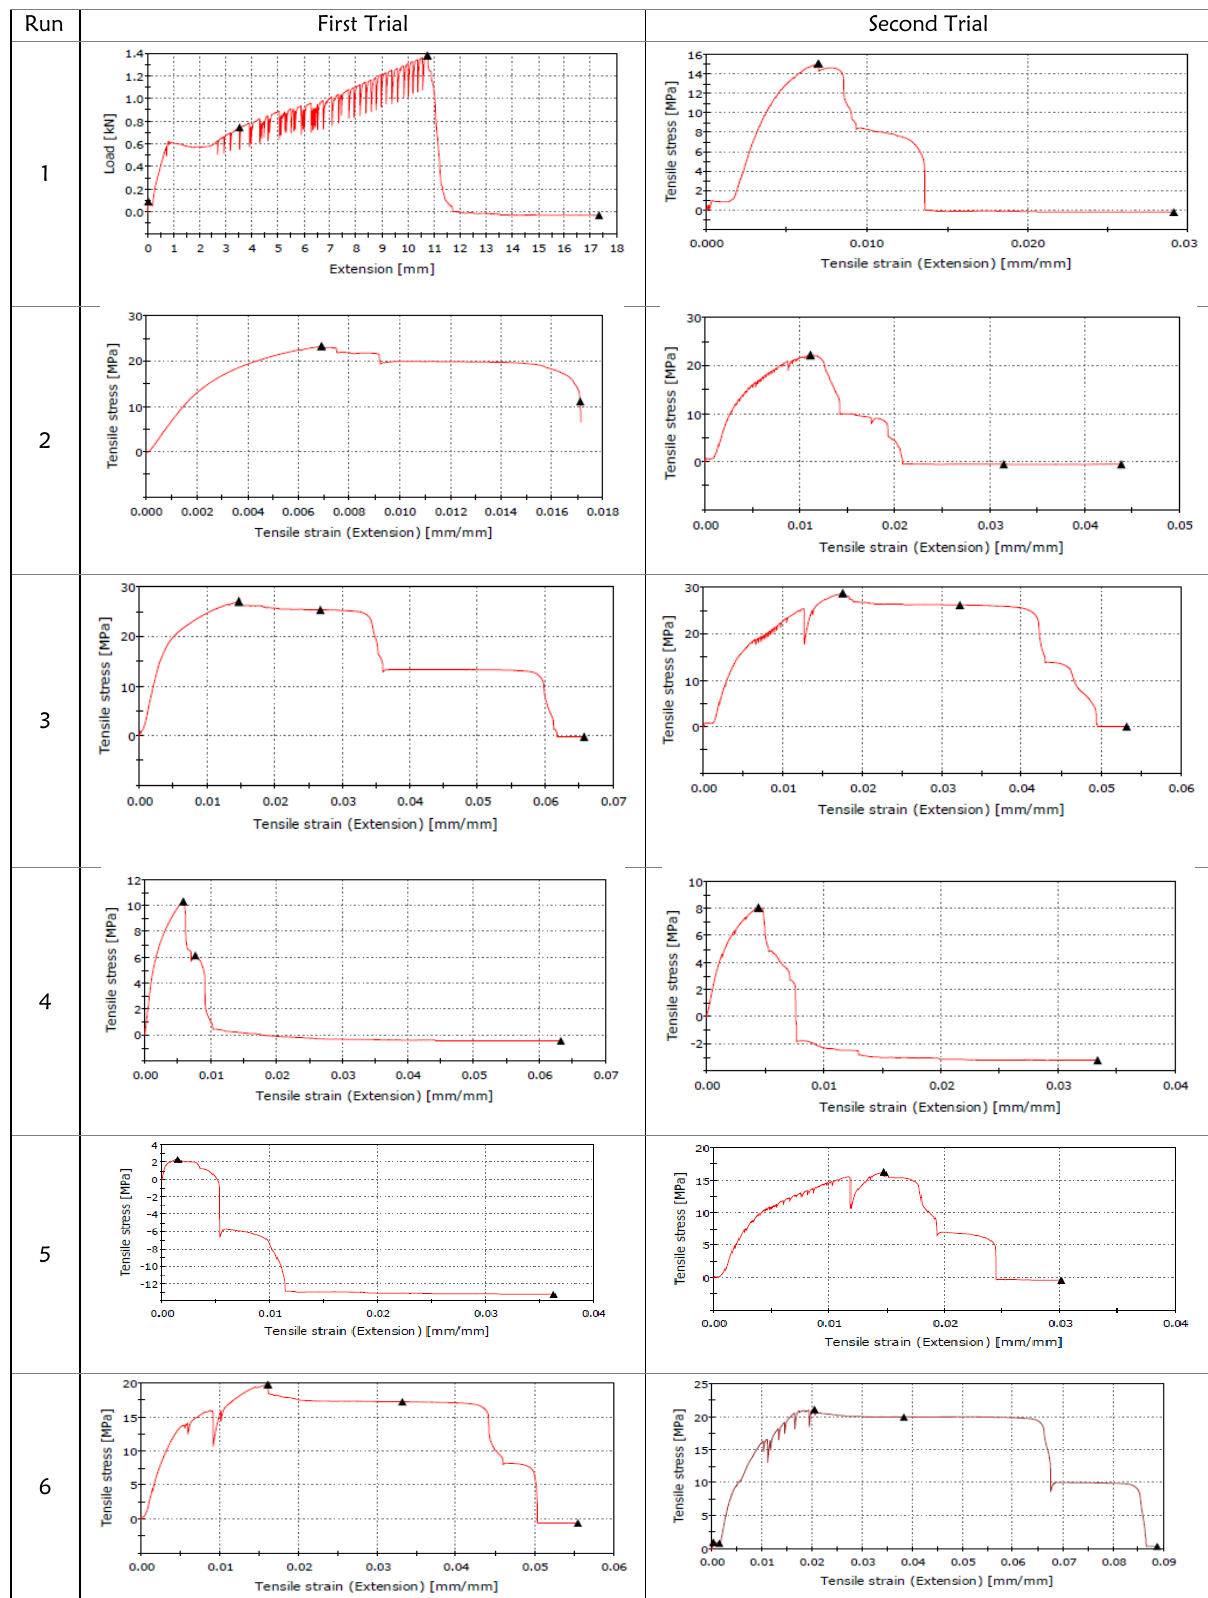
Table 2: Tensile stress-strain curve for